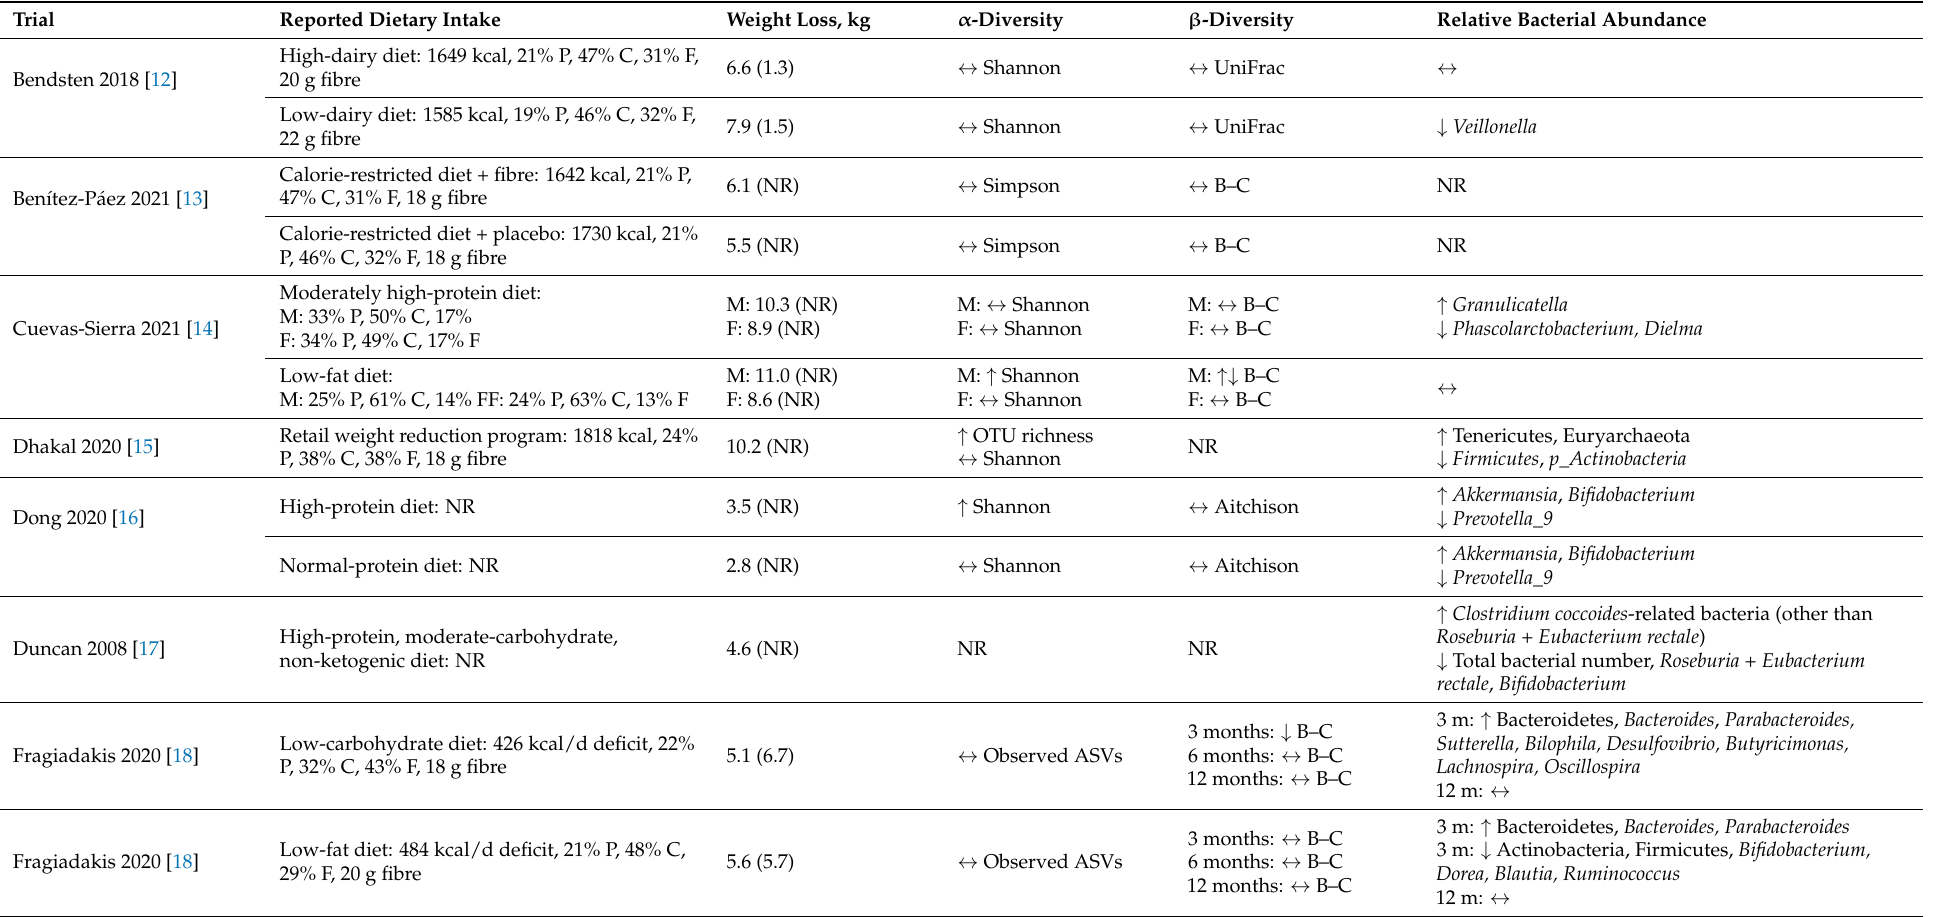
Table 2. Summary of the microbiota changes of included